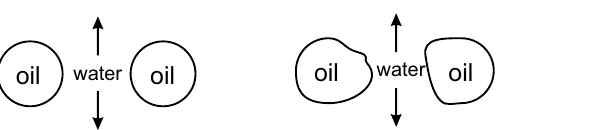
Figure 7. A schematic of two droplets coalescing and the role of capillary wave in the rupture of the aqueous film between these two